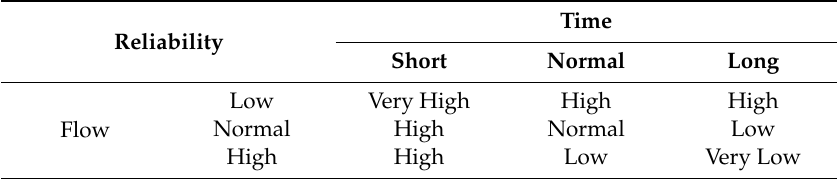
Table 25. Fuzzy rule